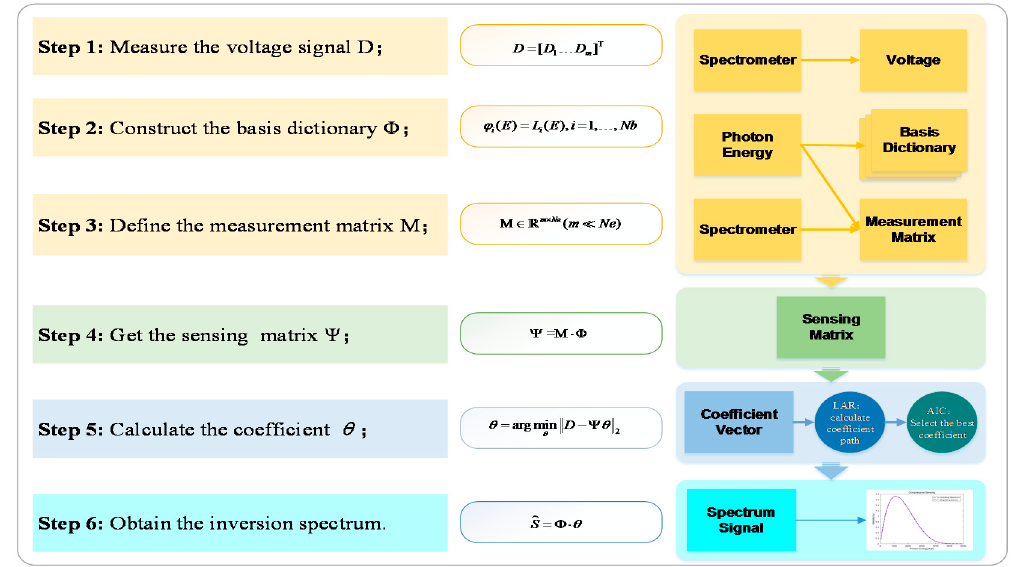
Figure 4. The process of spectrum unfolding based on compressive sensing.